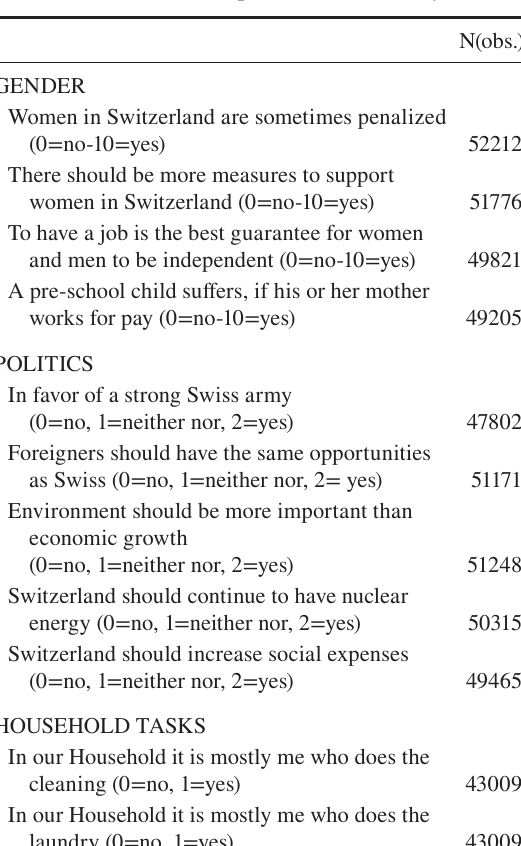
Table 1 Means of dependent variables by sex and t-tests of differences.